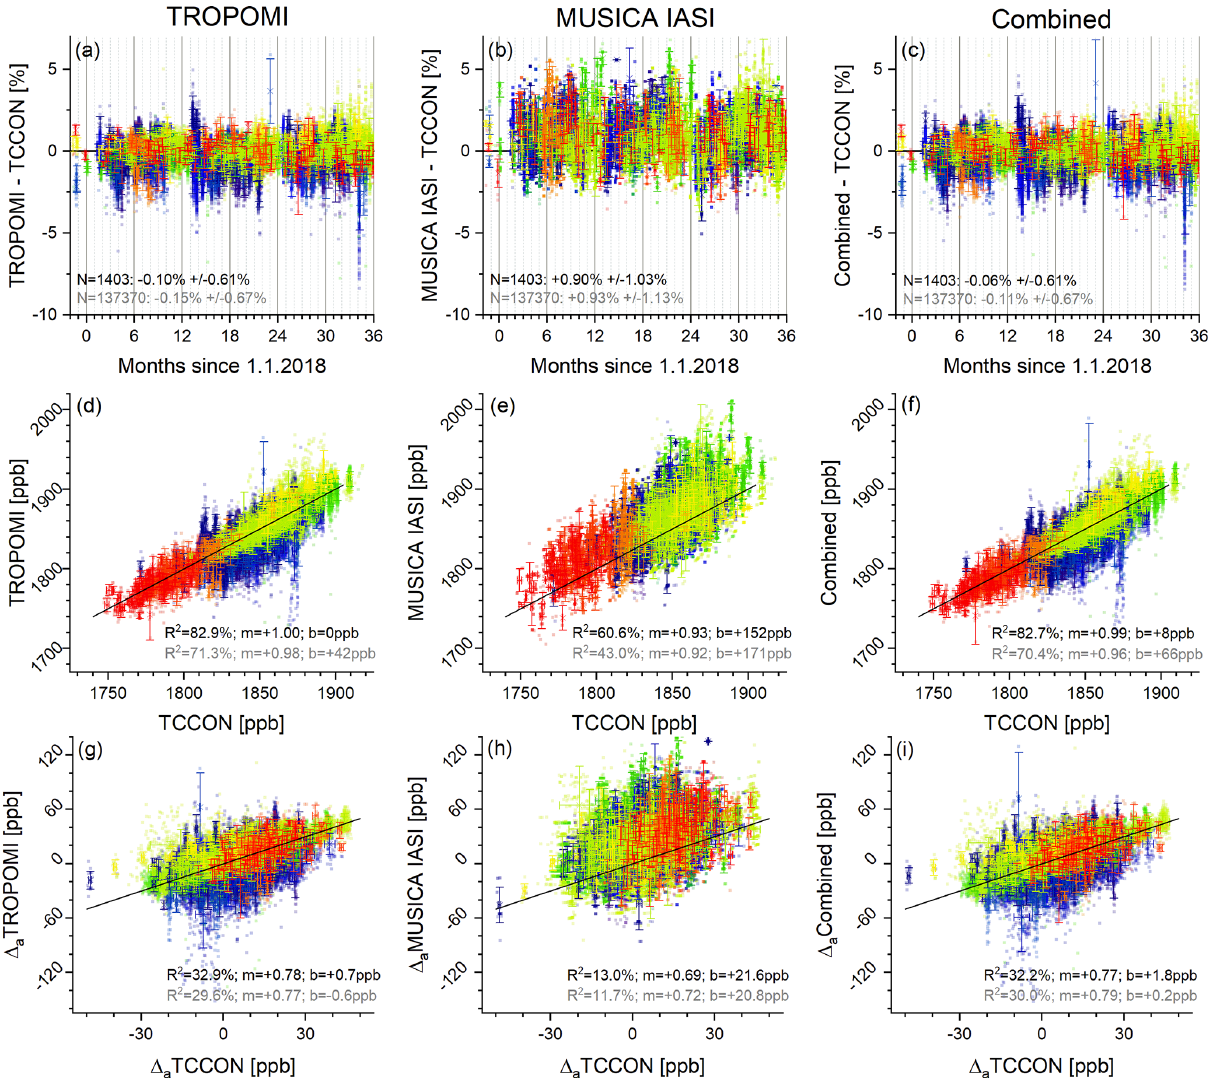
Figure 9. Comparison of the different XCH 4 satellite products with TCCON XCH 4 data from 14 globally representative stations (the different colours correspond to the stations as shown in Fig. 8a). Data for all individual coincidences are plotted in the background as squares, and daily mean data are depicted as crosses with error bars representing the 1 σ standard deviation (daily means are only calculated if there are at least three observations per day): (a–c) time series of the differences. (d–f) Correlations between TCCON and satellite data (the black line